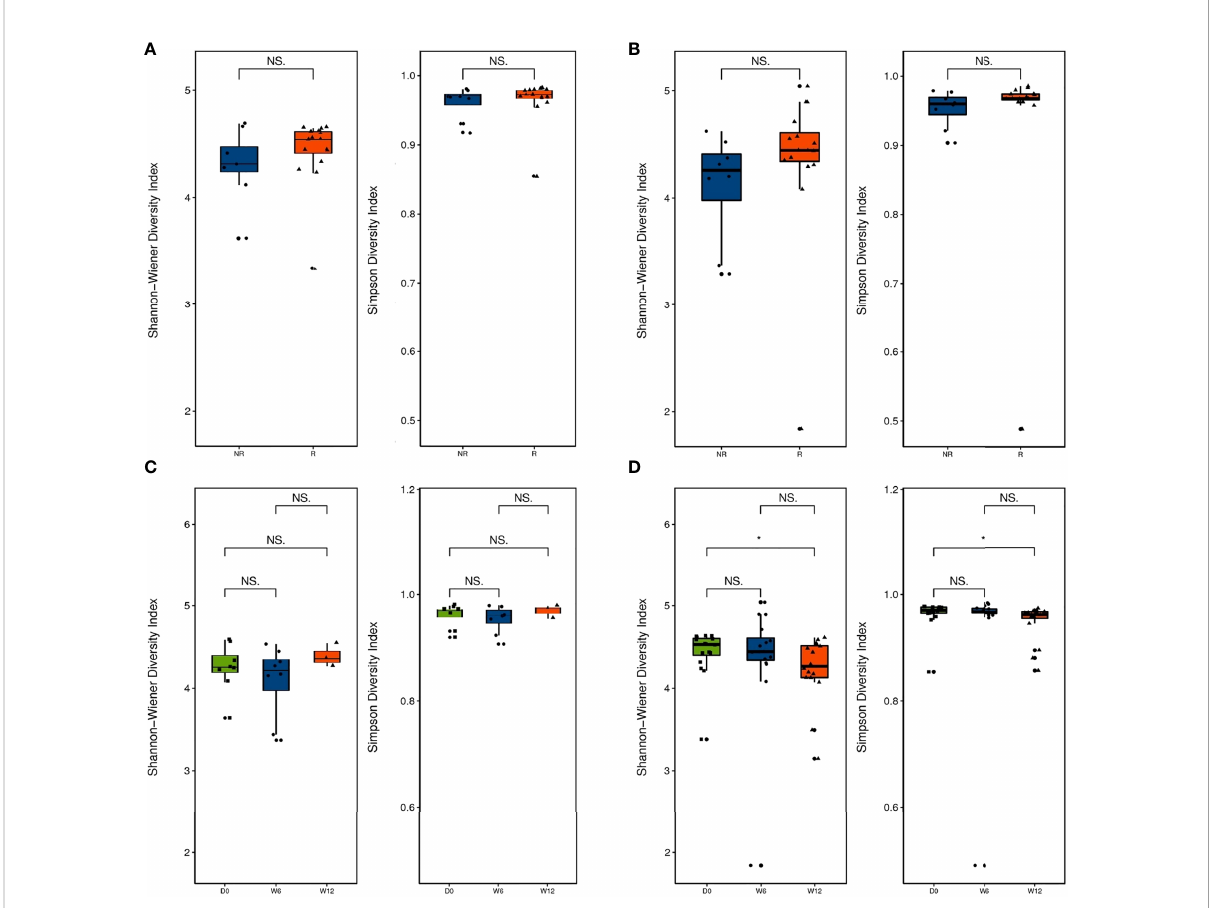
FIGURE 2 Diversity of the gut microbiota between the R group (n = 16) and NR group (n = 8, except at 12 weeks). (A) Alpha diversity was evaluated by the Shannon and Simpson indices at baseline and (B) 6 weeks. (C) Comparison of alpha diversity by the Shannon and Simpson indices at baseline, 6 weeks, and 12 weeks in the R group and (D) the NR group (n = 3 at 12 weeks). NS and *indicate values of P > 0.05, P < 0.05,